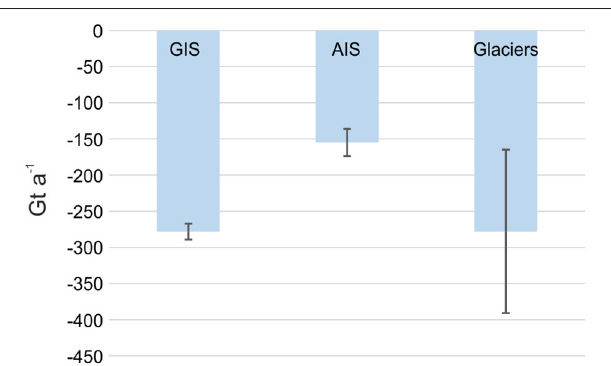
FIGURE 1 | Annual rates of ice loss for 2006–2015 from the Greenland Ice Sheet (GIS) and Antarctic Ice Sheet (AIS) (IPCC, 2019, Table 3.3) and all other global glaciers (IPCC, 2019, section 2.2.3, Table 2.A.1). The glacier losses are as great as Greenland’s but with much greater